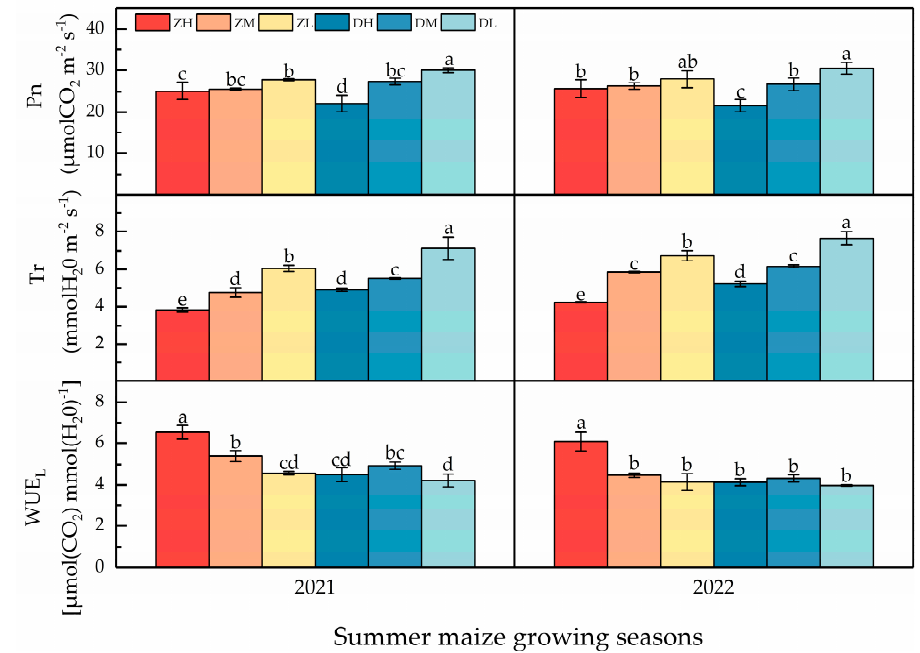
Figure 5. Effects of planting densities and genotypes on Pn, Tr, and WUE L at R2 (filling stage) in 2021 and 2022 summer maize growing seasons. Z represents Zhengdan 958, D represents Denghai 605; H represents high density, M represents middle density, L represents low density. Vertical bars represent standard errors. Bars labeled at the top of the column with different letters are significantly ( p < 0.05) different among treatments using LSD post hoc test.